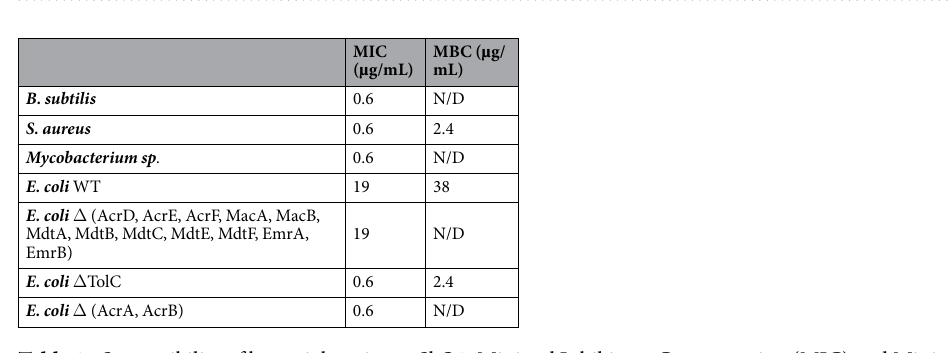
Table 1. Susceptibility of bacterial strains to SkQ1: Minimal Inhibitory Concentration (MIC) and Minimal Bactericidal Concentration (MBC)